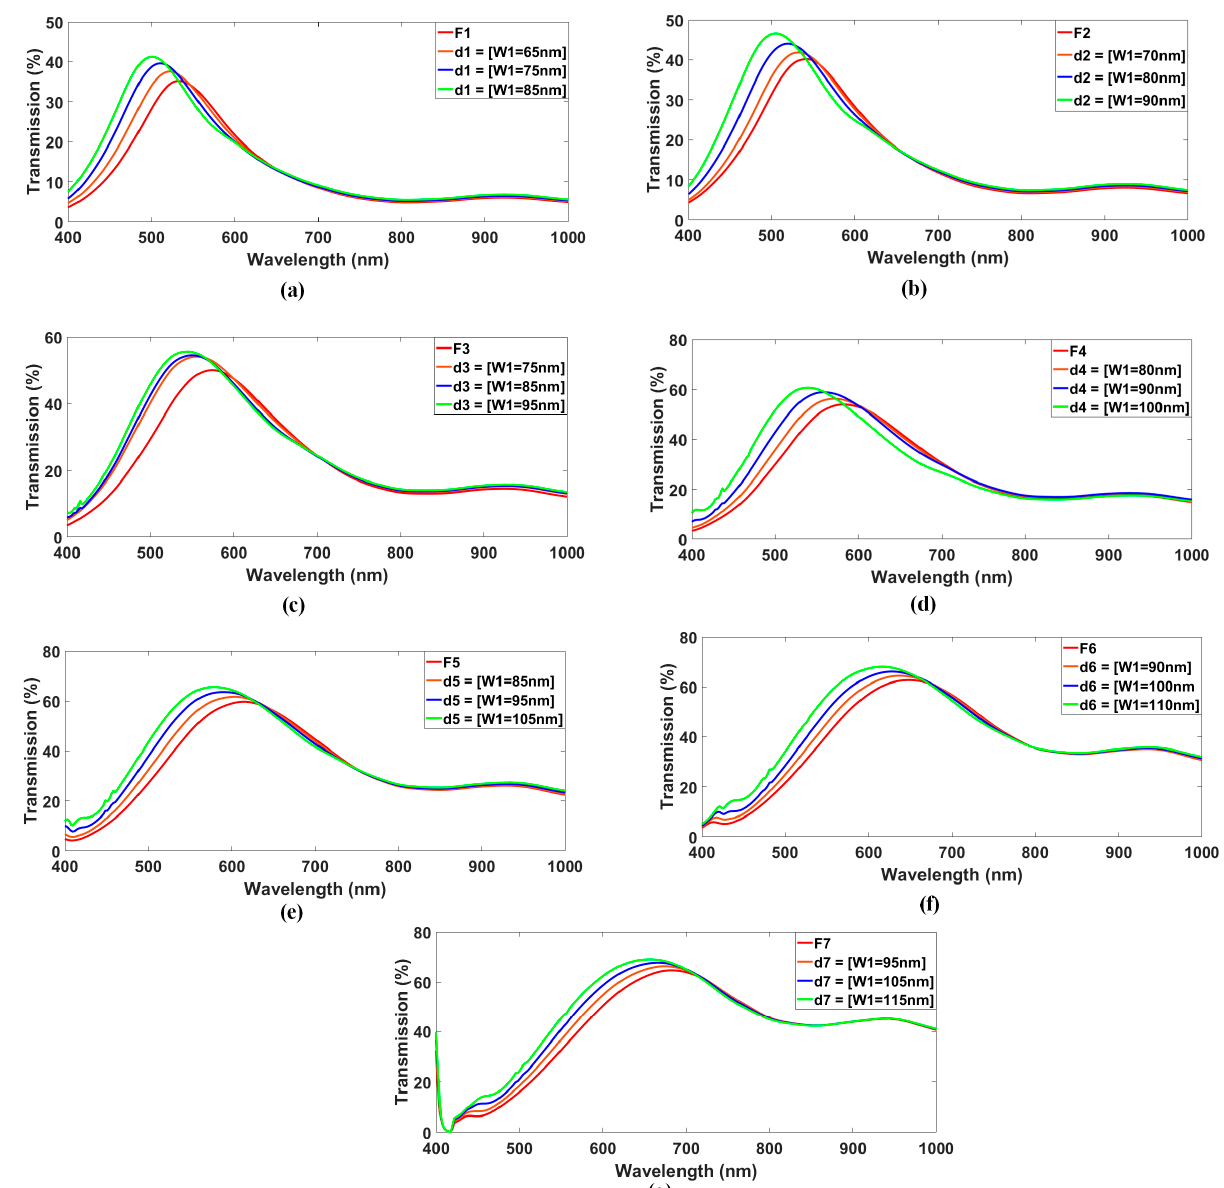
Figure 8. Calculated transmission spectra defective (asymmetric) structure by changing the width W1 of 7 EOT PCFs and representing the defect by d1, d2, d3, d4, d5, d6, and d7. ( a ) F1 compared with d1, ( b ) F2 compared with d2, ( c ) F3 compared with d3, ( d ) F4 compared with d4, ( e ) F5 compared with d5, ( f ) F6 compared with d6, and ( g ) F7 compared with d7.